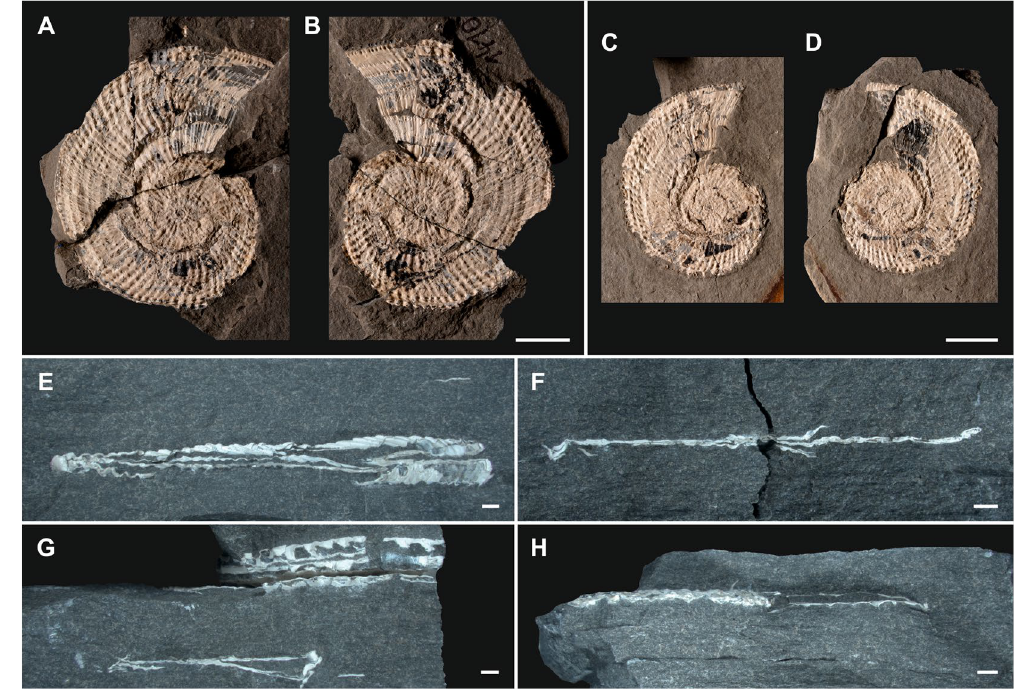
Figure 3. Ammonoid members of the Lower Carnian (Upper Triassic) Polzberg palaeobiota. ( A ) Austrotrachyceras minor , positive, lateral view, note change in adult shell ornamentation near aperture, NHMW 2021/0123/0131a; ( B ) A. minor , negative of ( A ), lateral view, NHMW 2021/0123/0131b; ( C ) A. minor , positive, lateral view, note change in adult shell ornamentation and black material near aperture representing the in situ Anaptychus , NHMW 2021/0123/0132a; ( D ) A. minor , negative of (C), lateral view, NHMW 2021/0123/0132b; ( E ) A. minor , crushed and compressed, horizontally embedded shell, sediment-filled body chamber, ventral view, NHMW 2021/0123/0133; ( F ) A. minor , crushed and compressed, horizontally embedded shell, body chamber, transect view, NHMW 2021/0123/0134; ( G ) A. minor , crushed and compressed, horizontally embedded shells, body chamber, top specimens ventral view on sediment-filled body chamber, lower specimen transect view, NHMW 2021/0123/0135a, NHMW 2021/0123/0135b; ( H ) A. minor , crushed and compressed, horizontally embedded shell, phragmocone (left) and sediment-filled body chamber (right), apertural view, NHMW 2021/0123/0136. Scale bars: ( A – D ) 10 mm, ( E – H ) scale bar: 1000 μm. Prepared by AL using CorelDRAW X7; www. corel draw.